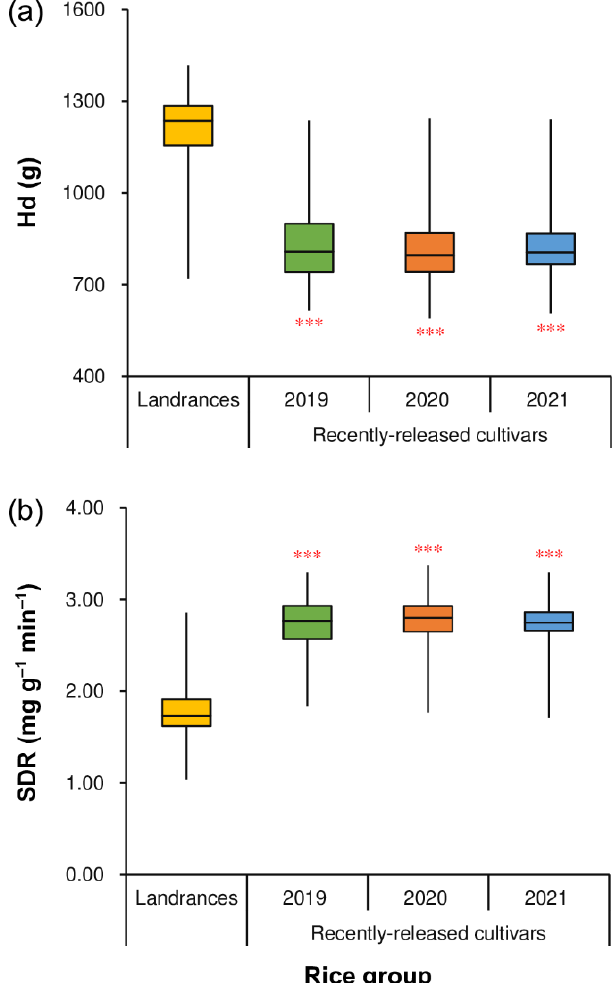
Figure 2. ( a ) Hardness (Hd) and ( b ) starch digestion rate (SDR) in landraces and recently-released cultivars of indica rice in China. The box-and-whisker plot shows the minimum (end of the lower whisker), 25th percentile (lower edge of the box), median (horizontal line within the box), 75th percentile (upper edge of the box), and maximum (end of the upper whisker) values of the data ( n = 706, 474, 645, and 717 for landraces and cultivars released in 2019, 2020, and 2021, respectively). *** denotes a significant difference between recently-released cultivars and landraces at the 0.001 probability